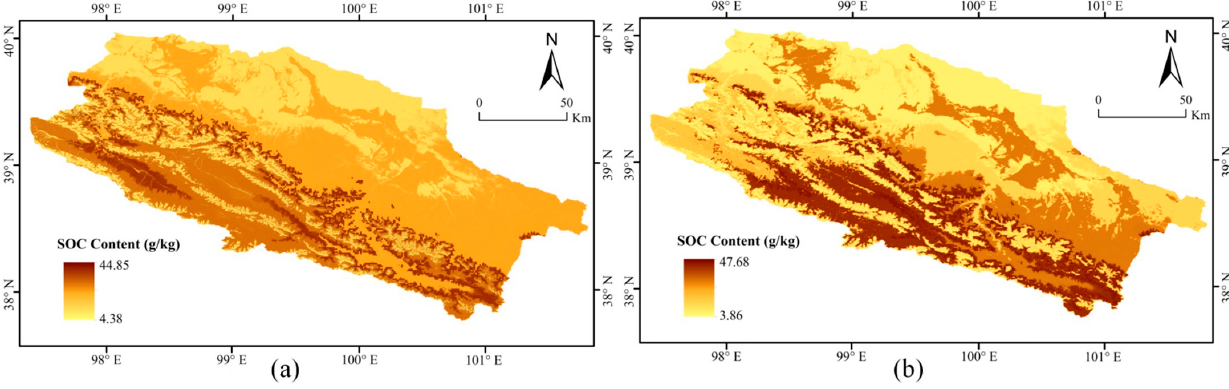
Figure 7. The spatial distribution of SOC content predicted by RF using commonly used variables ( a ) and commonly-used variables and phenological variables ( b